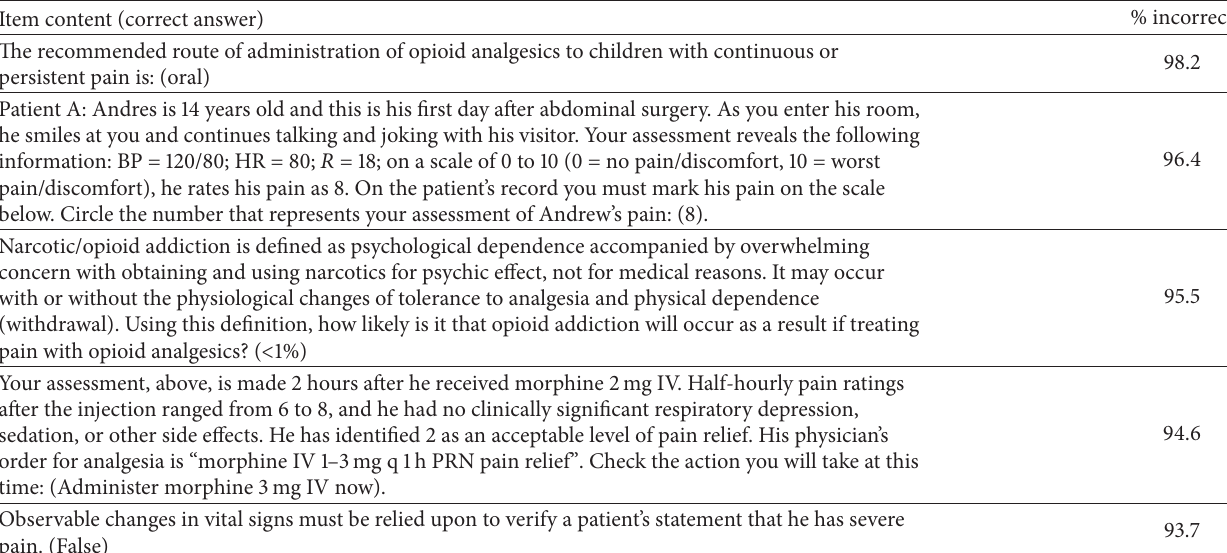
Table 3: Top 5 questions answered incorrectly by hospital nurses.